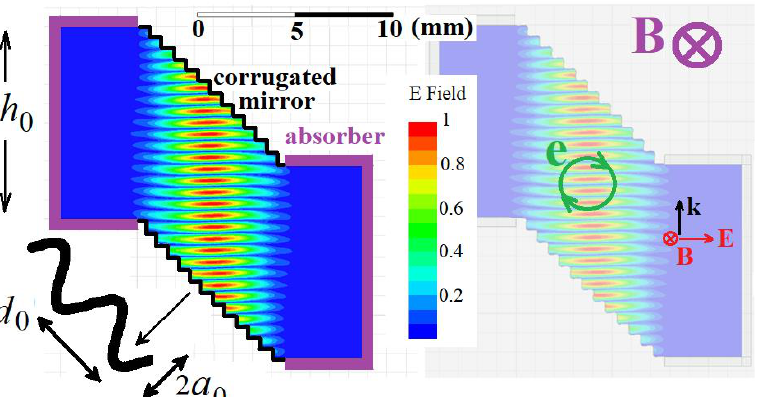
Figure 2. Eigenmode in the form of a standing wave confined by two metal diffraction gratings. The image is taken from HFSS. The electric field vector belongs to the picture plane, its absolute value is depicted by color. The “[” and “]”-shape areas are matched absorbers used to restrict the simulation area. The right picture illustrates cyclotron orbit of electrons on the background of the transverse cross-section of the gyrotron cavity, as well as orientation of electric and magnetic field in one of two traveling components forming the standing eigenwave. The color scale is in arbitrary units.